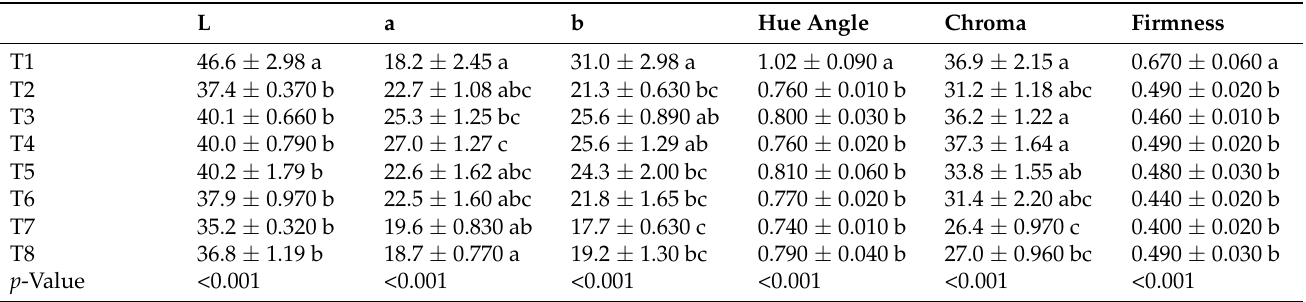
Table 6. Colour and firmness parameters in tomato fruit receiving UWP (T1–T7) and Hoagland solution (T8)